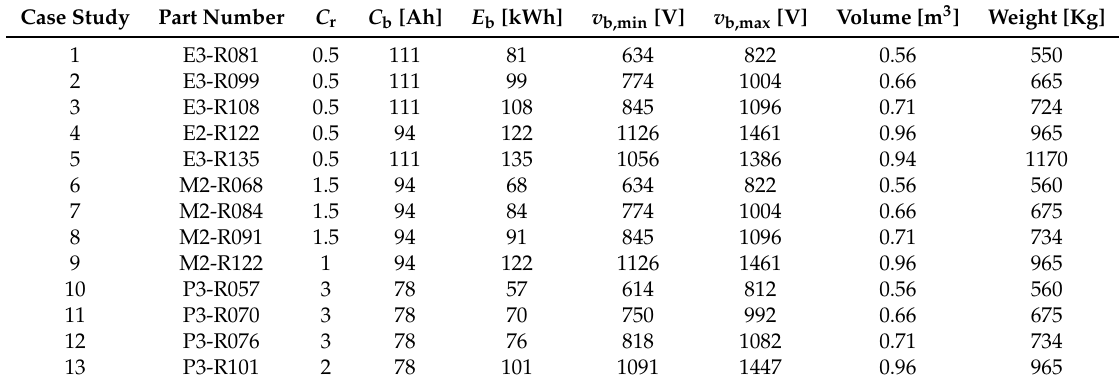
Table 2. LIBs’ data